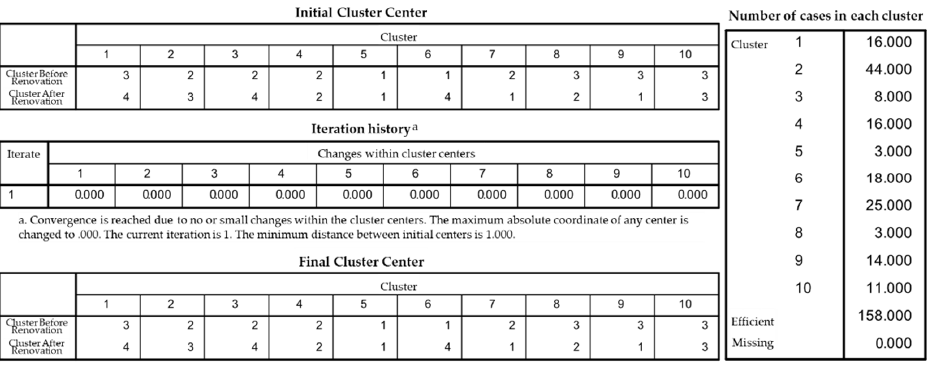
Figure A5. K ‐ means clustering analysis of changes in the attributes of historical buildings.